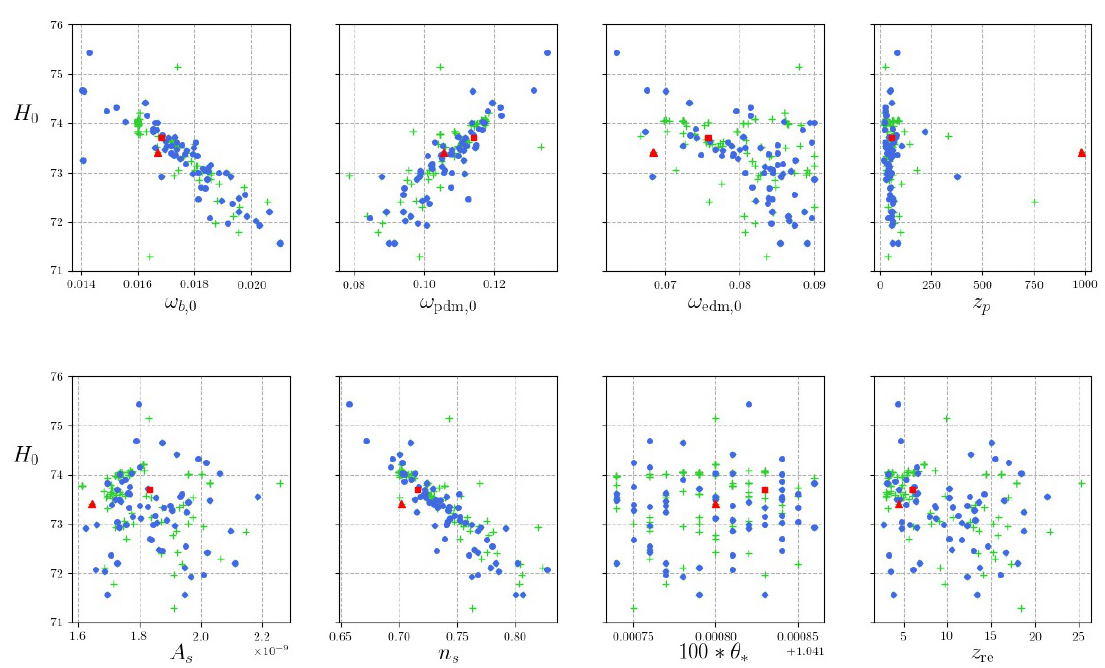
Figure 3. Scatter plots of H 0 for fitted parameter values, requiring that χ 2 < 21,700 (best-fit: χ 2 = 21,192.6 for SU(2) CMB , χ 2 = 20,940.1 for SU(2) CMB + V ± ). Crosses and dots refer to SU(2) CMB + V ± and SU(2) CMB , whose best-fit parameter values are indicated by a solid triangle and a solid square,